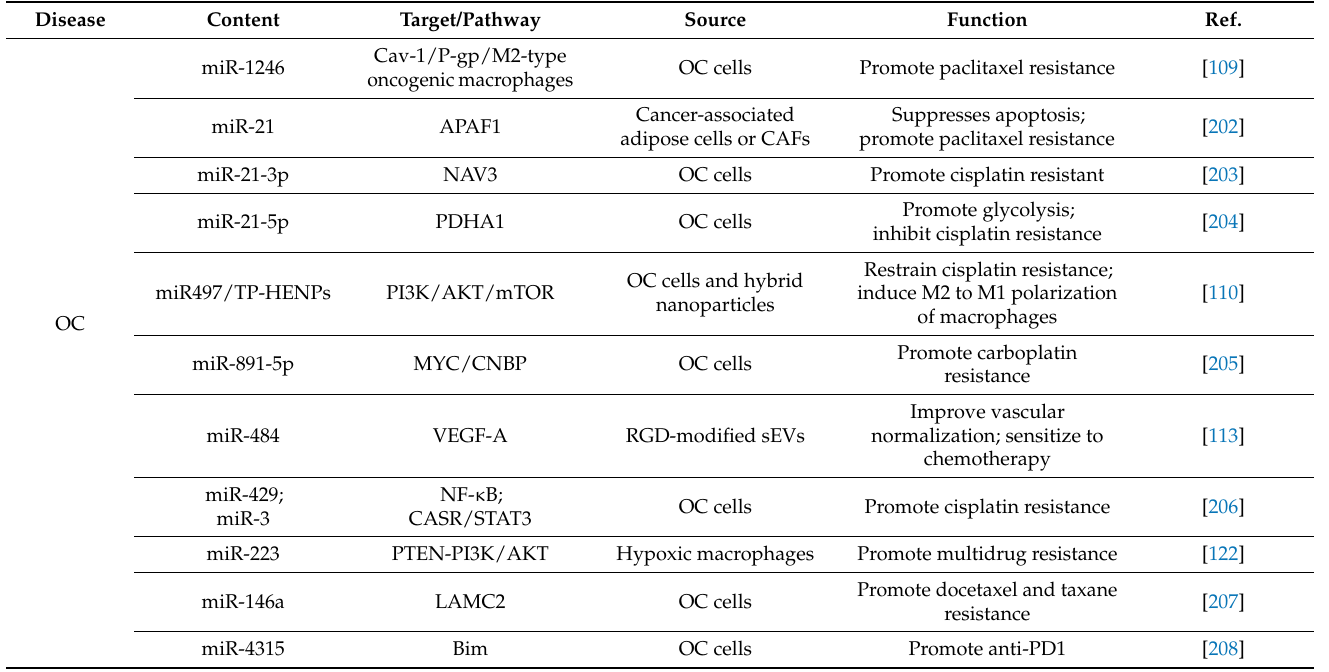
Table 3. sEV contents serve as therapeutic targets for resistance in gynecologic